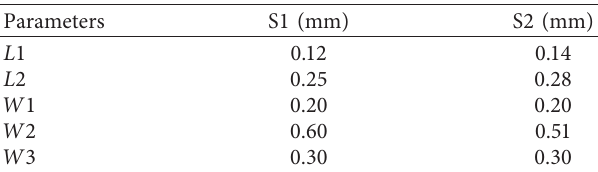
Figure 4: Structure of the FRA integrated RF MEMS switches. Table 1: Parameters of the transition structure of RF MEMS switch integrated in microstrip